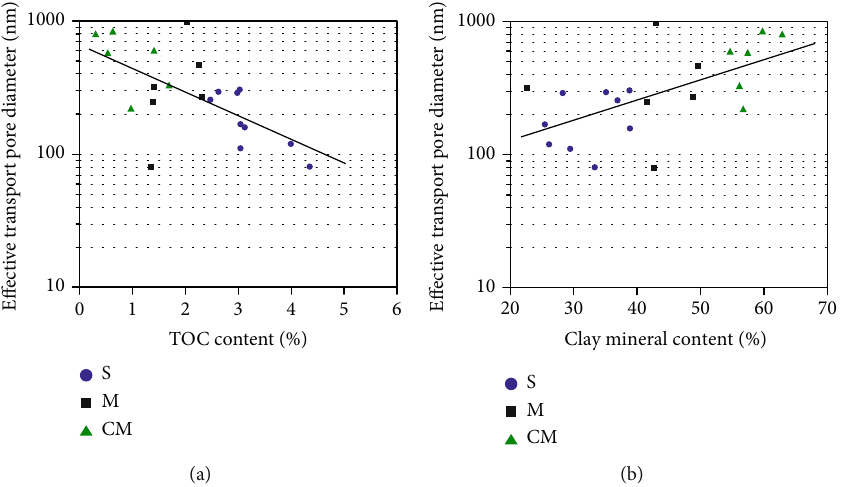
Figure 16: The relationship between (a) TOC content, (b) clay mineral content, and transport pore diameter of shale samples.